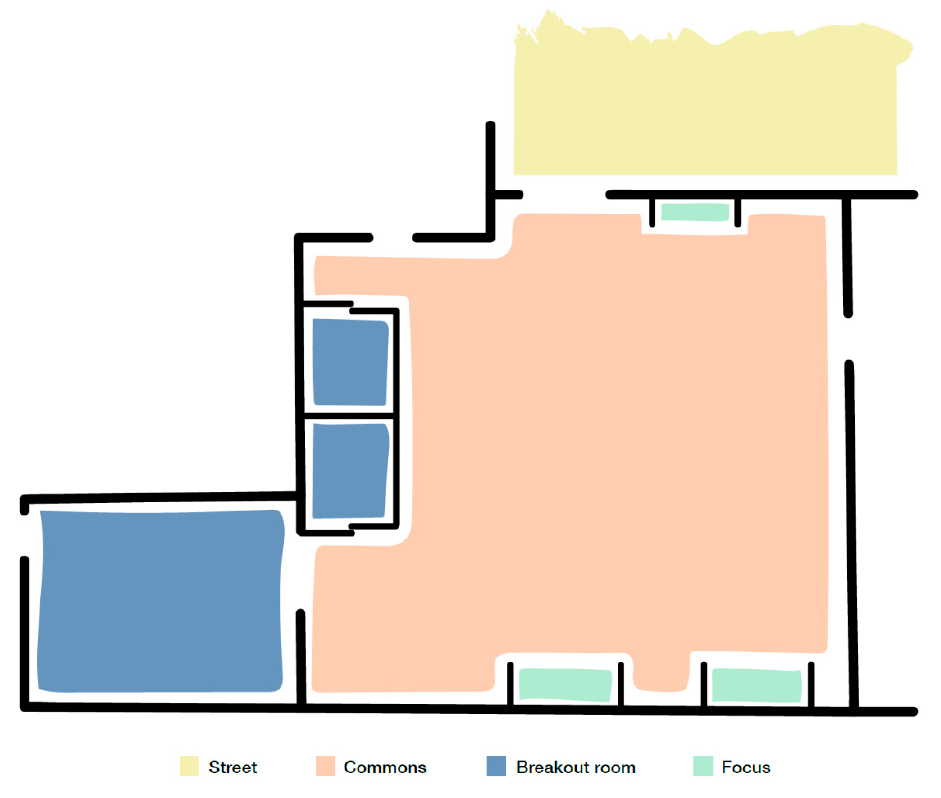
Figure 2. TeLE in Valley School.